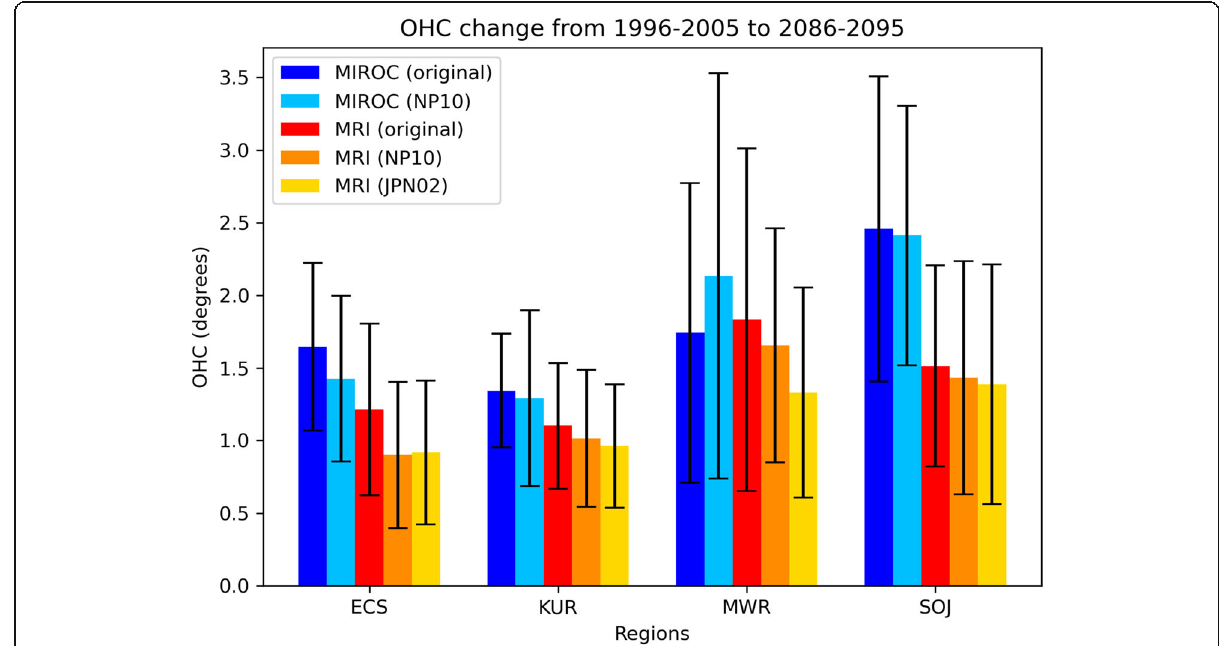
Fig. 8 OHC changes for four rectangular regions (shown in Fig. 3d) from the 1996 – 2005 mean to the 2086 – 2095 mean, comparing the NP10, JPN02, and their original products. The box bars denote the average of RCP2.6 and RCP8.5, and the error bars the range from RCP2.6 to RCP8.5. Note that the OHCs for the ECS region are derived from the surface 0 – 300 m layer temperature (the others are derived from the surface 0 – 700 m